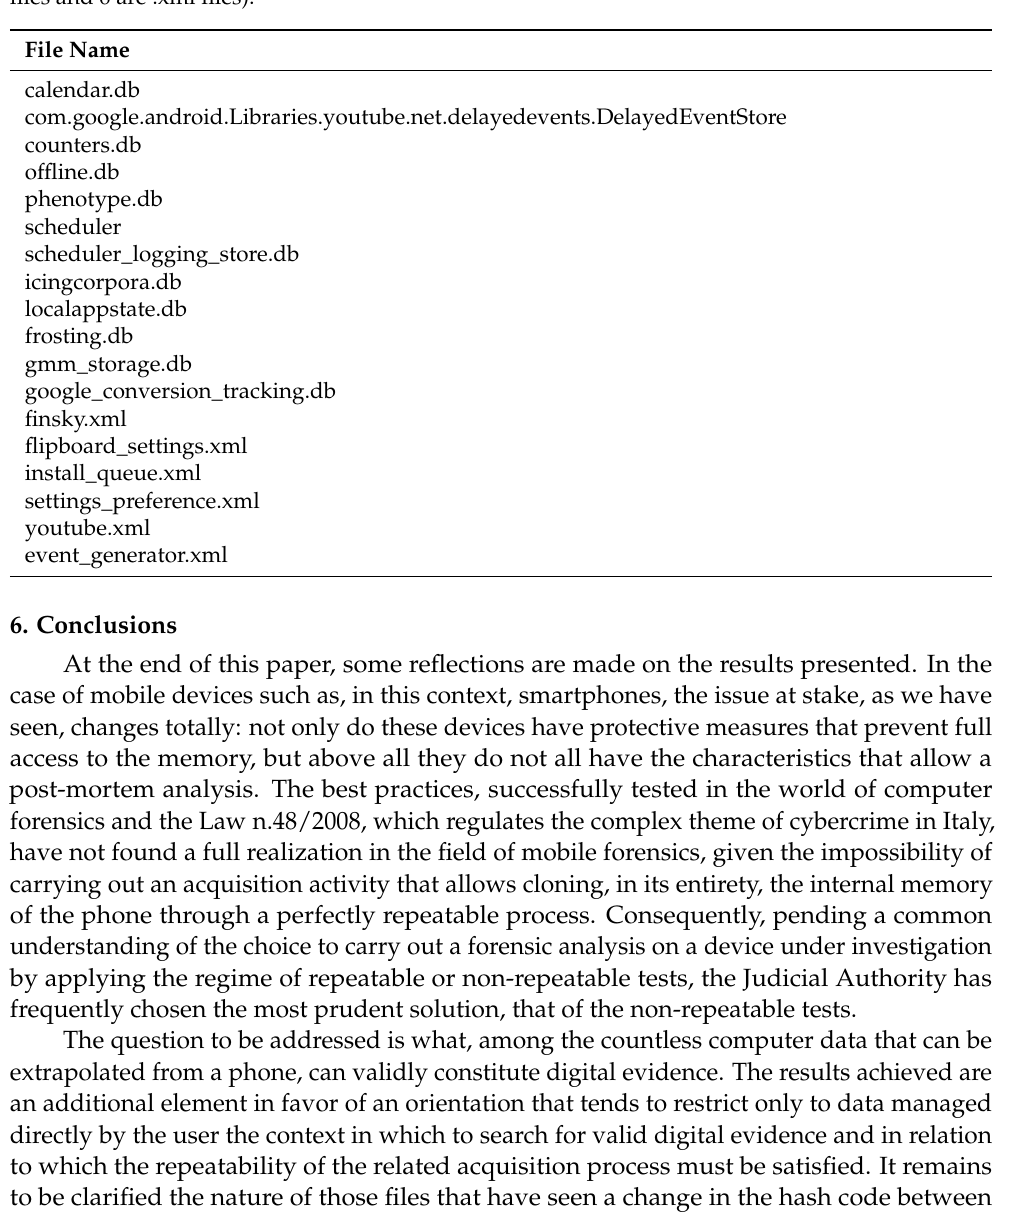
Table 2. List of the extracted files that have been modified (with a different hash code. (12 are .db files and 6 are .xml